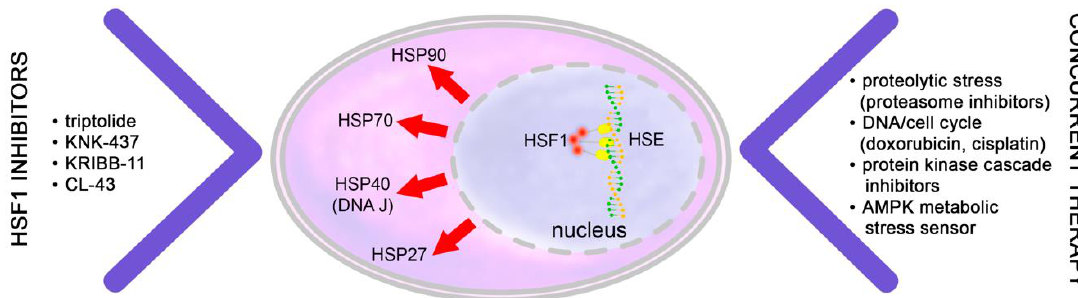
Figure 2. Inactivation of HSF1 transcription activator synergizes with anti-cancer therapy. Activation of HSF1 leads to elevated synthesis of the set of protective heat shock proteins while inhibition of the regulator (shown at the left side) combined with cytotoxic agents (right column) leads to enhanced tumor cell death.